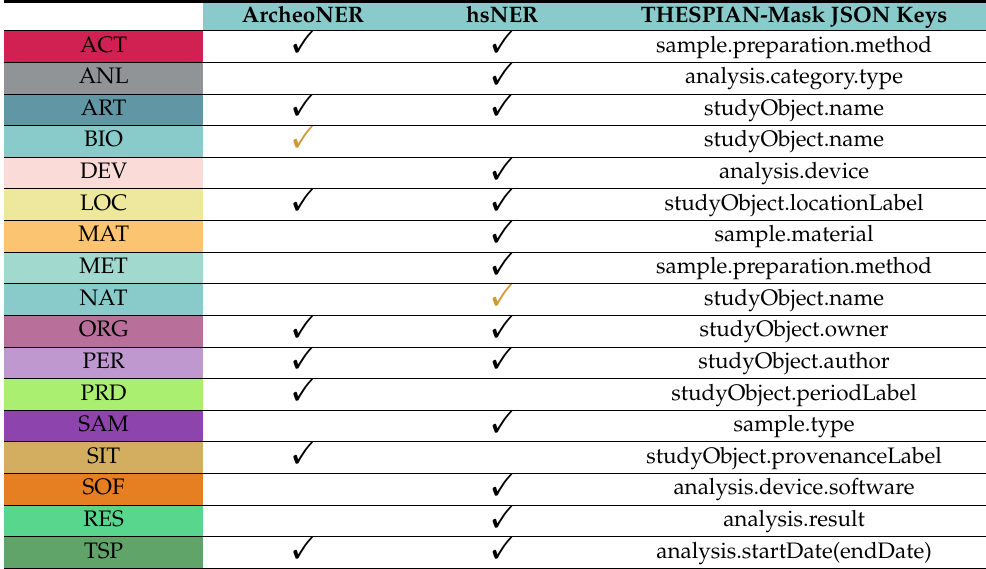
Table 1. List of entity labels (by alphabetical order) for ArcheoNER and hsNER datasets. The three- letter abbreviation is described in the text. The last column reports the THESPIAN-Mask JSON keys associated with the NER Label. The BIO and NAT checkbox appears in yellow when they refer to the same